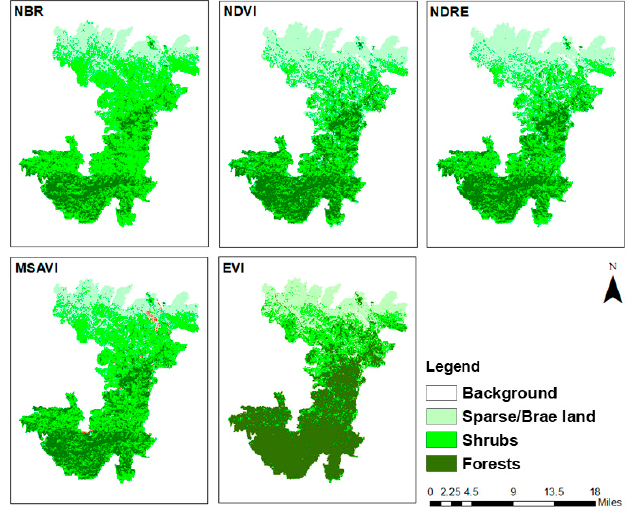
Figure 4. Comparative analysis of monitoring results with different spectral indexes.